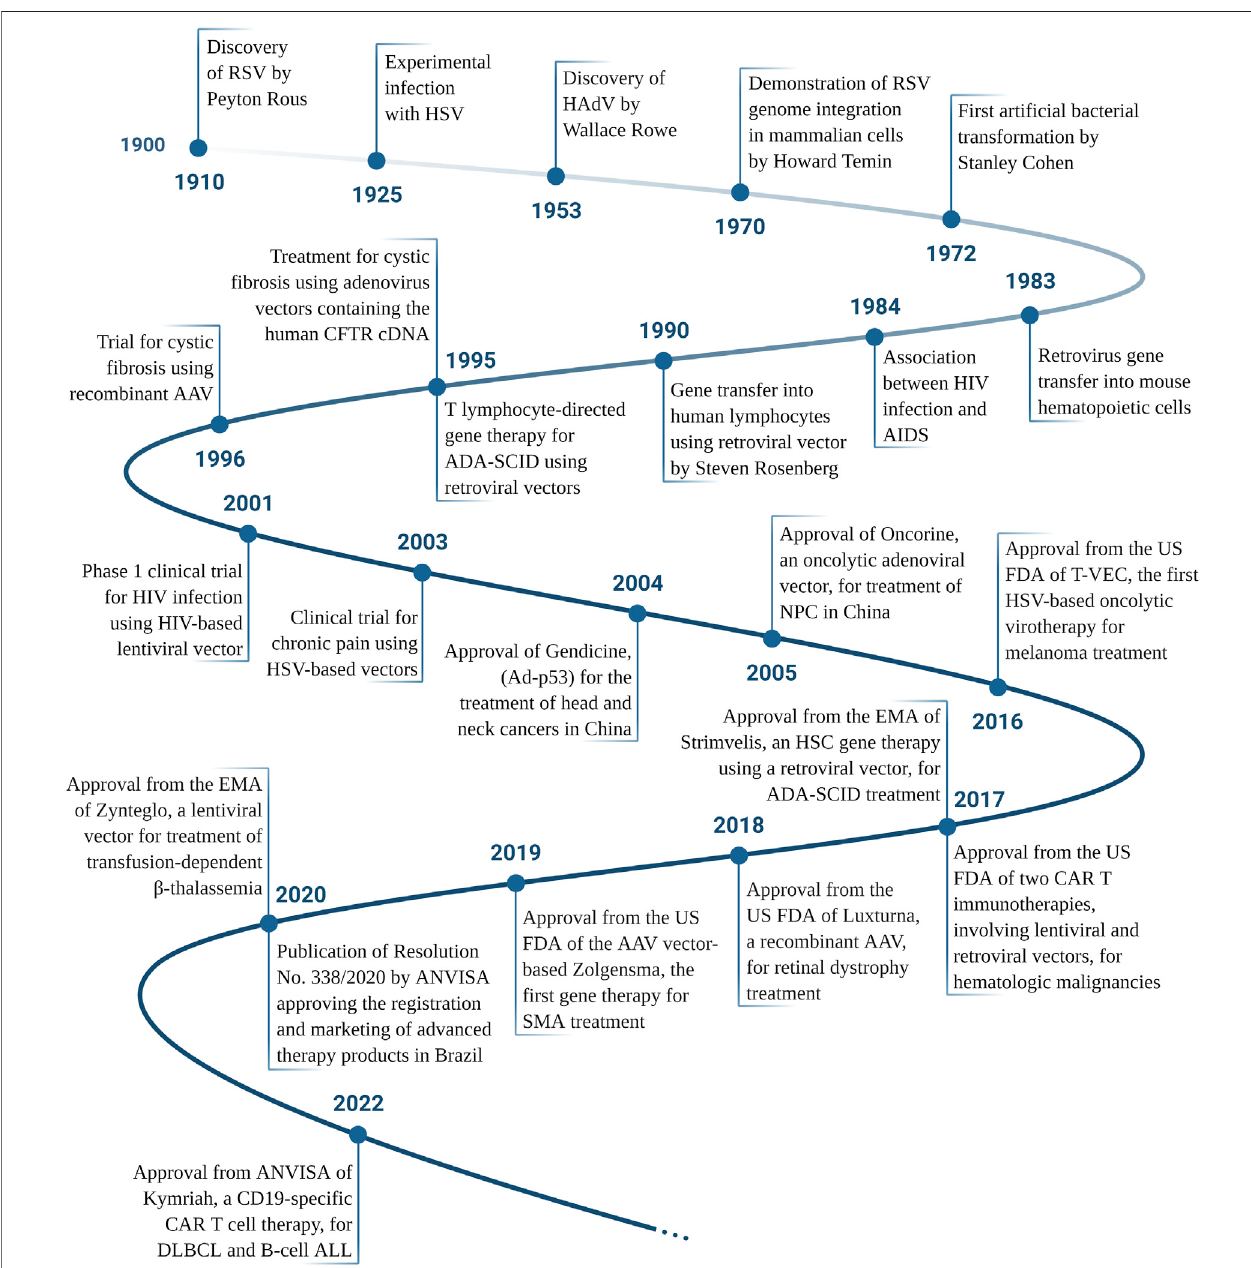
FIGURE 2 | Timeline of the main achievements in the gene therapy and virotherapy fi elds, according to the date of publication. RSV, Rous Sarcoma Virus; HSV, Herpes Simplex Virus; HAdV, Human adenovirus; HIV, Human Immunode fi ciency Virus; AIDS, Acquired Immunode fi ciency Syndrome; ADA-SCID, Adenosine Deaminase Severe Combined Immunode fi ciency; CFTR, Cystic Fibrosis Transmembrane Conductance Regulator; AAV, Adeno-Associated Virus; NPC, nasopharyngeal carcinoma; US FDA, The United States Food and Drug Administration; EMA, European Medicines Agency; CAR, Chimeric Antigen Receptor; SMA, Spinal Muscular Atrophy; ANVISA, Agência Nacional de Vigilância Sanitária (National Agency for Sanitary Vigilance, the federal body in Brazil that regulates new drugs, among other health related items); DLBCL, Diffuse Large B-Cell Lymphoma; ALL, Acute Lymphoblastic Leukemia. Please see Supplementary Table S1 for references. Created with